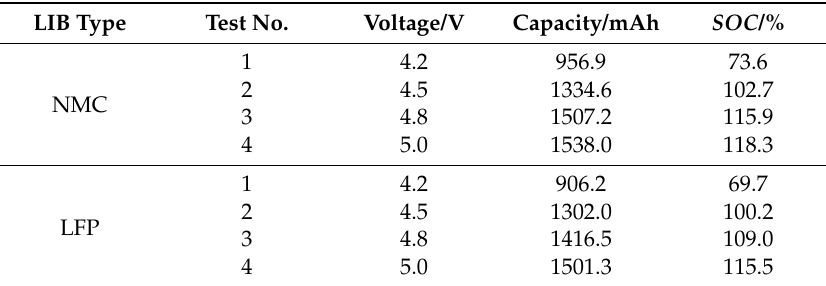
Table 1. The experimental configurations.